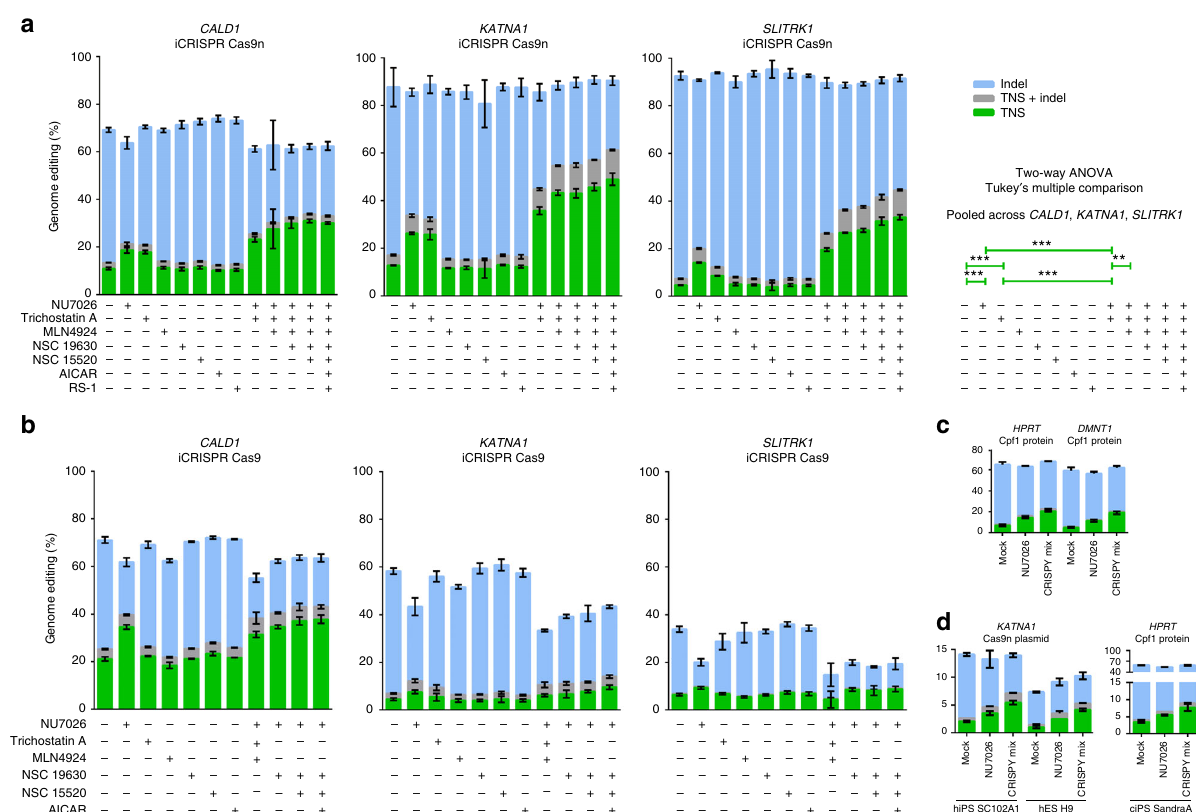
Fig. 3 Impact of small-molecule combinations on targeted nucleotide substitution (TNS) ef fi ciency in iPSCs and hESCs. Shown are TNS ef fi ciencies in CALD1 , KATNA1 , and SLITRK1 with Cas9n and Cas9, and in HPRT and DNMT1 with Cpf1. Small molecules have an additive effect on TNS ef fi ciency with Cas9n ( a ) but not with Cas9 ( b ) in the 409-B2 iCRISPR hiPSC lines. TNS of HPRT and DNMT1 in 409-B2 hiPSCs with recombinant Cpf1 was increased using the CRISPY mix as well ( c ). Using the CRISPY mix, TNS ef fi ciency was also increased in SC102 A1 hiPSCs and H9 hESCs with plasmid-delivered Cas9n-2A- GFP (GFP-FACS enriched), and in chimpanzee SandraA ciPSCs with recombinant Cpf1 ( d ). Shown are TNS, TNS + indels, and indels with green, gray, or blue bars, respectively. Error bars show the SD of three technical replicates for a , b , and c , and two technical replicates for d . Concentrations used were 20 µ M of NU7026, 0.01 µ M of Trichostatin A, 0.5 µ M MLN4924, 1 µ M NSC 19630, 5 µ M NSC 15520, 20 µ M AICAR, and 1 µ M RS-1. CRISPY mix indicates a small-molecule mix of NU7026, Trichostatin A, MLN4924, and NSC 15520. Statistical signi fi cances of TNS ef fi ciency changes was determined using a two- way ANOVA and Tukey ’ s multiple comparison pooled across the three genes CALD1 , KATNA1 , and SLITRK1 . Genes and treatments were treated as random and fi xed effect, respectively. P -values are adjusted for multiple comparison (** P ≤ 0.01, *** P ≤ 0.001). Overall, there was a clear treatment effect (F(12, 24) = 32.954, P ≤